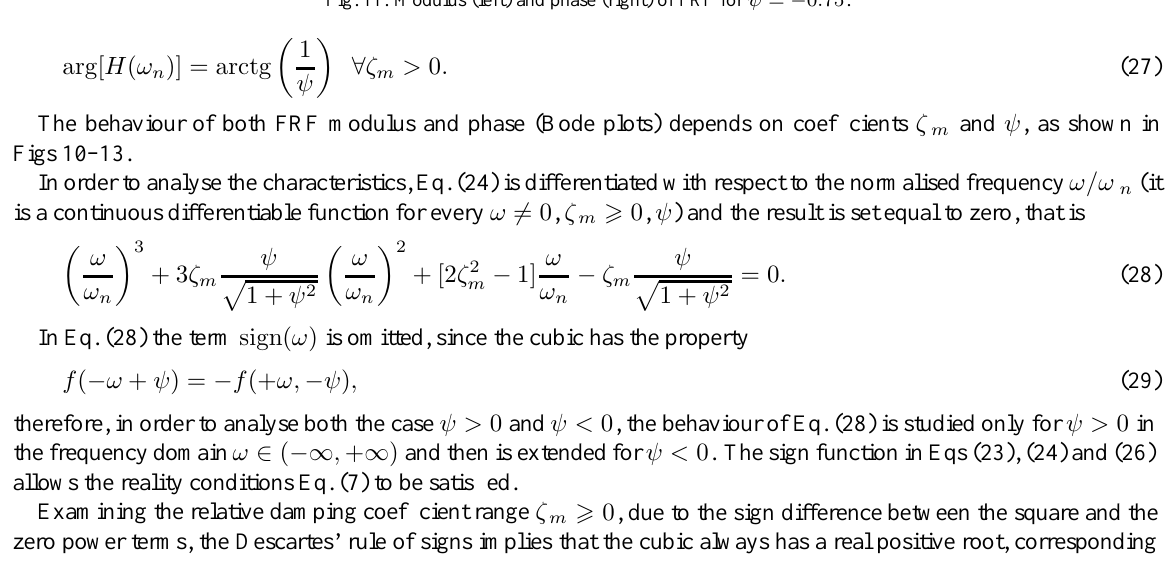
Fig. 11. Modulus (left) and phase (right) of FRF for ψ = − 0 . 75